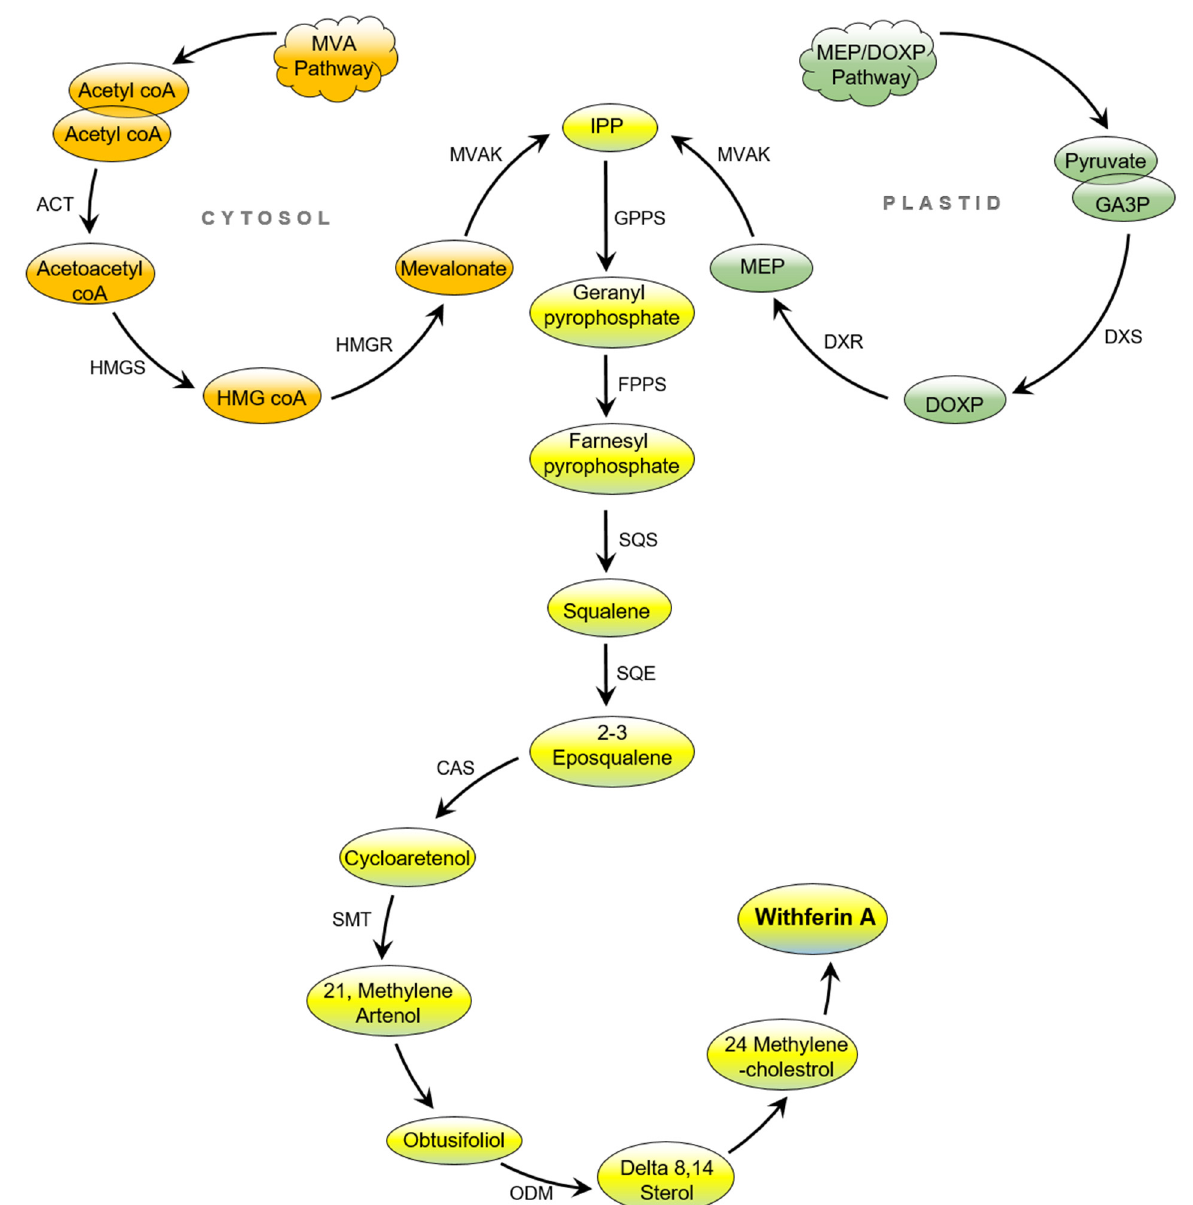
Figure 1. Biosynthesis of WA. Abbreviations: ACT: acetyltransferase; HMGS: hydroxymethyl glutaryl CoA synthase; HMG-CoA: 3-hydroxy-3-methylglutaryl-co enzyme; HMGR: 3-hydroxy-3-methylglutaryl-coenzyme A reductase; MVAK: mevalonate kinase; IPP: 3-isopentenyl pyrophosphate; GPPS: geranyl pyrophosphate synthase; FPPS: farnesyl diphosphate synthase; SQS: squalene synthase; SQE: squalene epoxidase; CAS: cycloartenol synthase; SMT: sterol methyl transferase; ODM: obtusifoliol-14-demethylase; DOXP: deoxy xylulose pathway; MEP: methyl erythreitol pathway; DXS: 1-deoxy- D -xylulose-5-phosphate synthase; DXR: 1-deoxy- D -xylulose-5-phosphate reductase; WA: withaferin A.